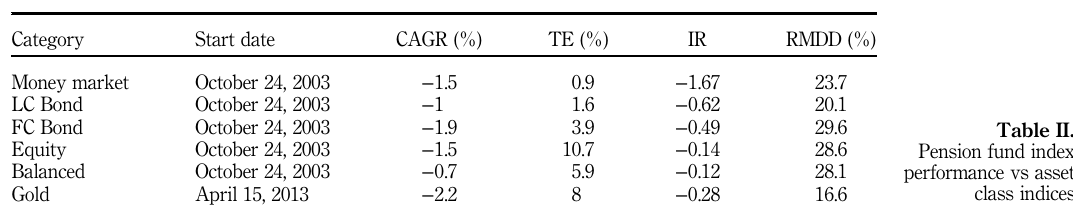
Table II. Pension fund